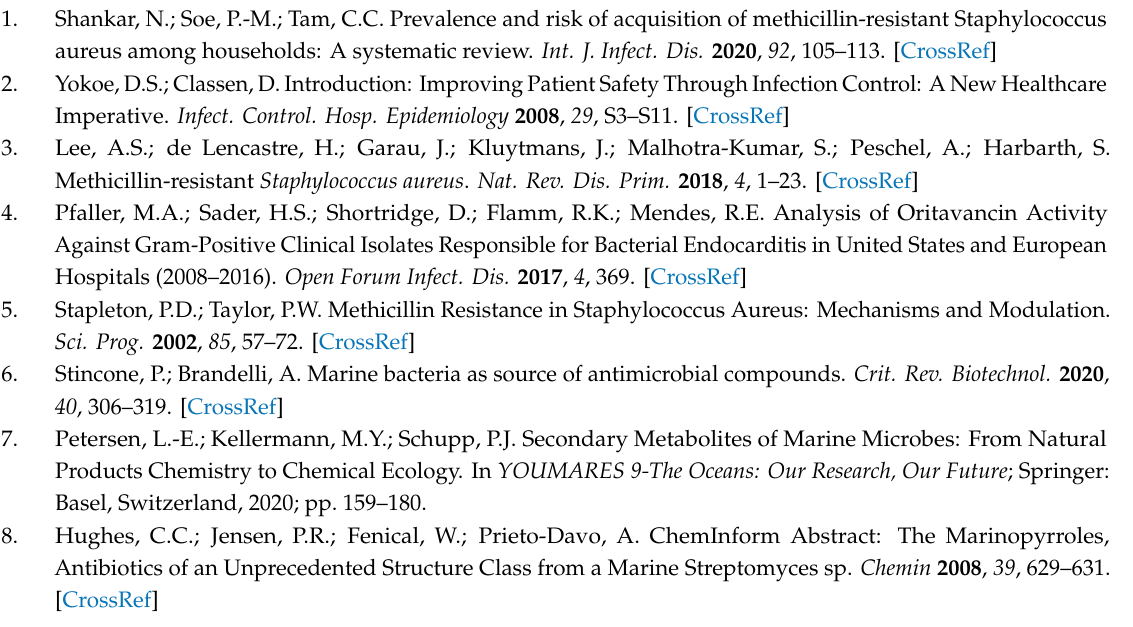
Figure S1: chromatographic data and HR-ESI-MS data, as well as 1D and 2D data for mersaquinone ( 1 ), and 1D and 2D NMR data for compounds 2-4. Table S1: NMR spectroscopic data for compounds 1 and 2 . Figure S2. 1H NMR data of mersaquinone (1), 500 MHz, DMSO-d6; Figure S3. 13C NMR data of mersaquinone (1), 125 MHz, DMSO-d6.; Figure S4. gHSQC NMR data of mersaquinone (1), 500 MHz, DMSO-d6; Figure S5. 1H-1H COSY NMR data of mersaquinone (1), 500 MHz, DMSO-d6; Figure S6. gHMBC NMR data of mersaquinone (1), 500 MHz, DMSO-d6; Figure S7. 1H NMR data of compound 2, 500 MHz, DMSO-d6; Figure S8. 13C NMR data of compound 2, 125 MHz, DMSO-d6; Figure S9. 1H-1H COSY NMR data of compound 2, 500 MHz, DMSO-d6; Figure S10. gHSQC NMR data of compound 2, 500 MHz, DMSO-d6; Figure S11. gHMBC NMR data of compound 2, 500 MHz, DMSO-d6; Figure S12. 1H NMR data of compound 3, 500 MHz, DMSO-d6; Figure S13. 13C NMR data of compound 3, 125 MHz, DMSO-d6; Figure S14. gHSQC NMR data of compound 3, 500 MHz, DMSO-d6; Figure S15. gHMBC NMR data of compound 3, 500 MHz, DMSO-d6; Figure S16. 1H NMR data of compound 4, 500 MHz, DMSO-d6; Figure S17. 13C NMR data of compound 4, 125 MHz,